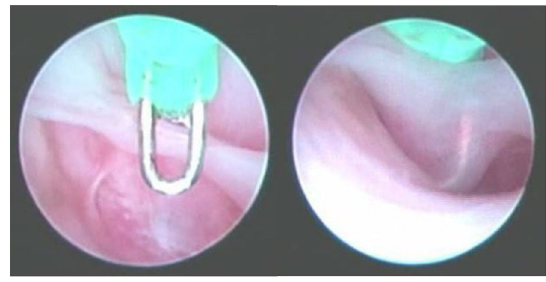
Fig. 3 Cystoscopic view of the anterior urethral valve (case 2) and resection of the valves